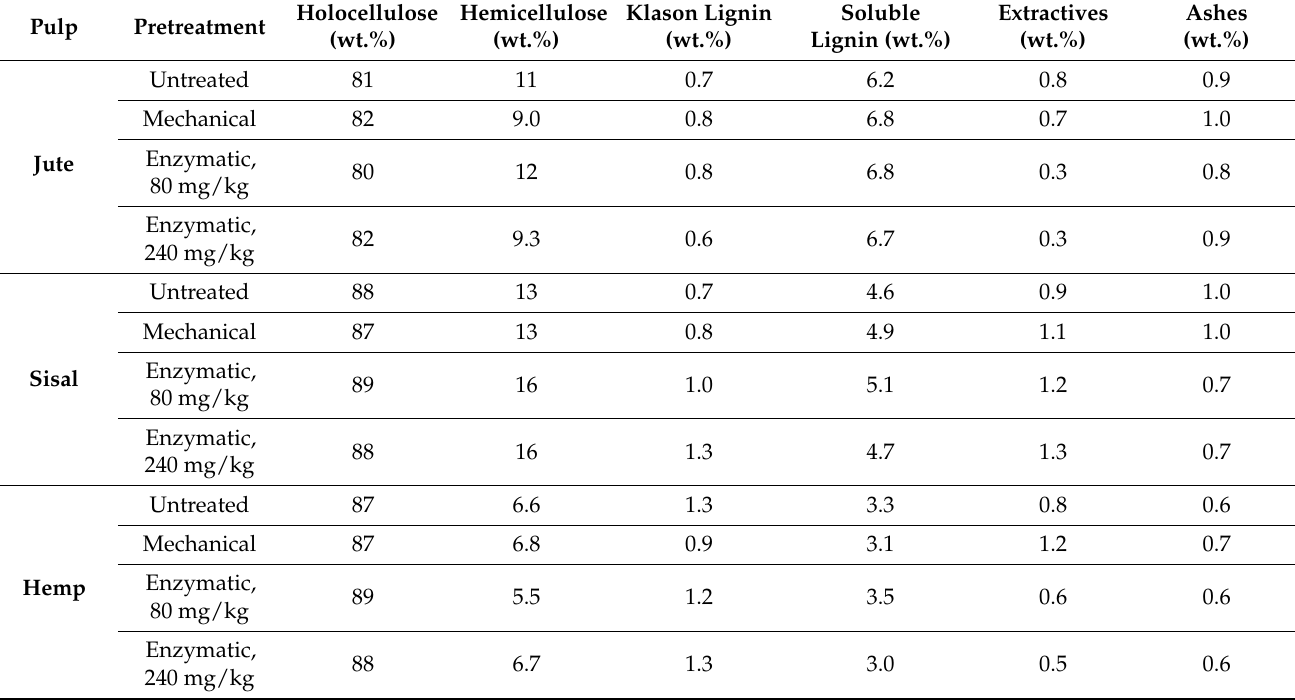
Table A1. Chemical composition of the pulps after each of the pretreatments before fibrillation, compared to the original pulp in each case.